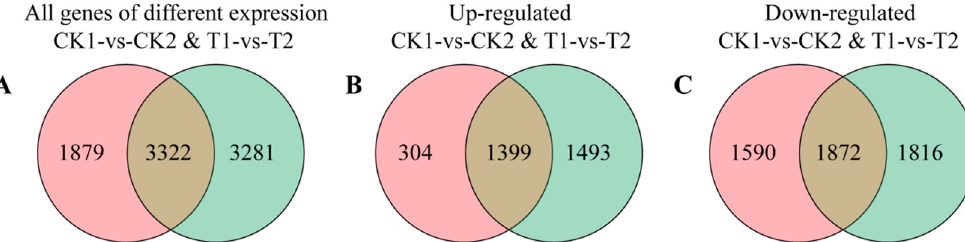
Figure 2. Venn diagrams of all genes and differentially expressed genes (DEGs) in skin samples between 5-aza-dC-treated and control groups of bagged “Granny Smith” apples. ( A ) Intersection of the Venn diagram showing all DEGs identified in pair analyses (CK1 vs. CK2 and T1 vs. T2). ( B , C ) Intersection of the Venn diagram showing up- and down-regulated DEGs between pairs, respectively.